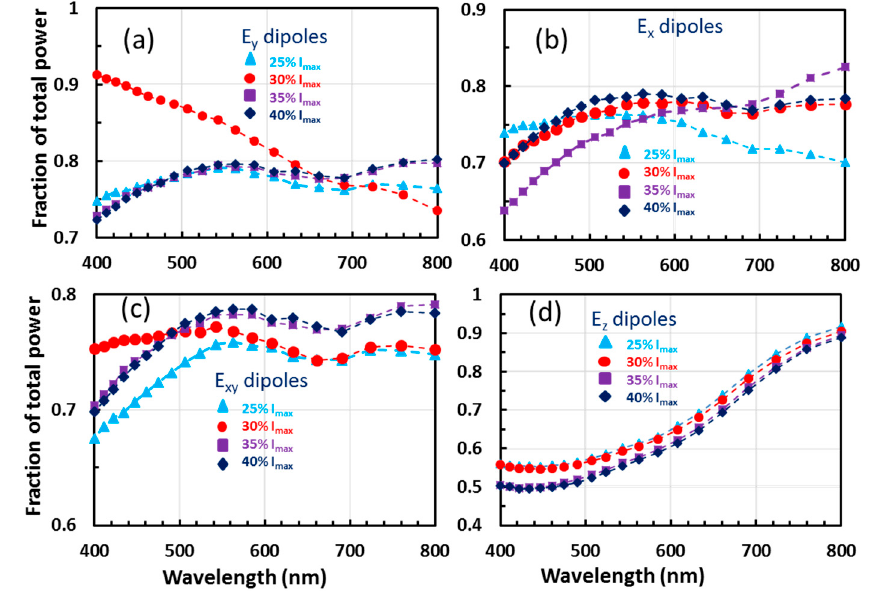
Figure 5. ( a ) Fraction of total emitted power (light in glass substrate over total emitted power) as a function of the wavelengths for different exposure thresholds of 25% I max , 30% I max , 35% I max , and 40% I max for the E y dipoles ( a ), E x dipoles ( b ), E xy dipoles ( c ), and E z dipoles ( d ).